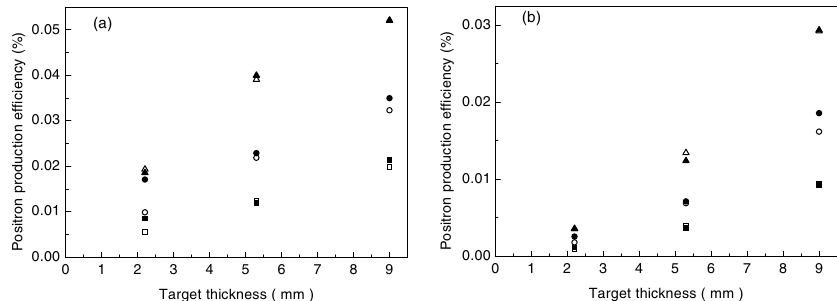
FIG. 6. Positron production efficiency from crystal (a) and amorphous (b) targets depending on thickness. Open symbols: our calculation; filled symbols: results from Fig. 5 of [16]; open triangles are for p (cid:16) 20 Mev =c , open circles are for p (cid:16) 15 Mev =c , and open squares are for p (cid:16) 10 Mev =c